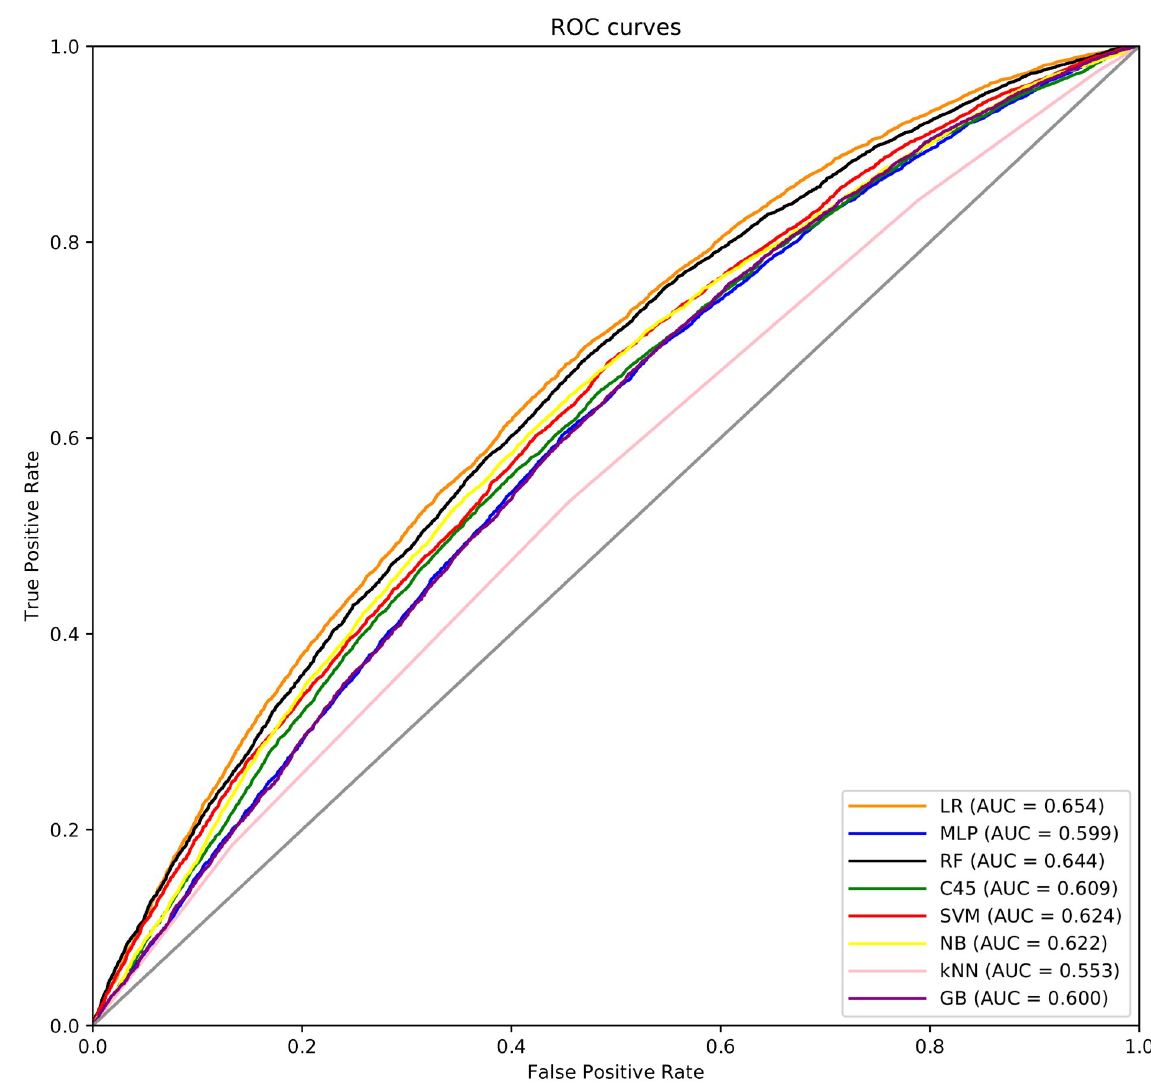
Fig 2. ROC curves for the best models obtained for the 5-years-end-point